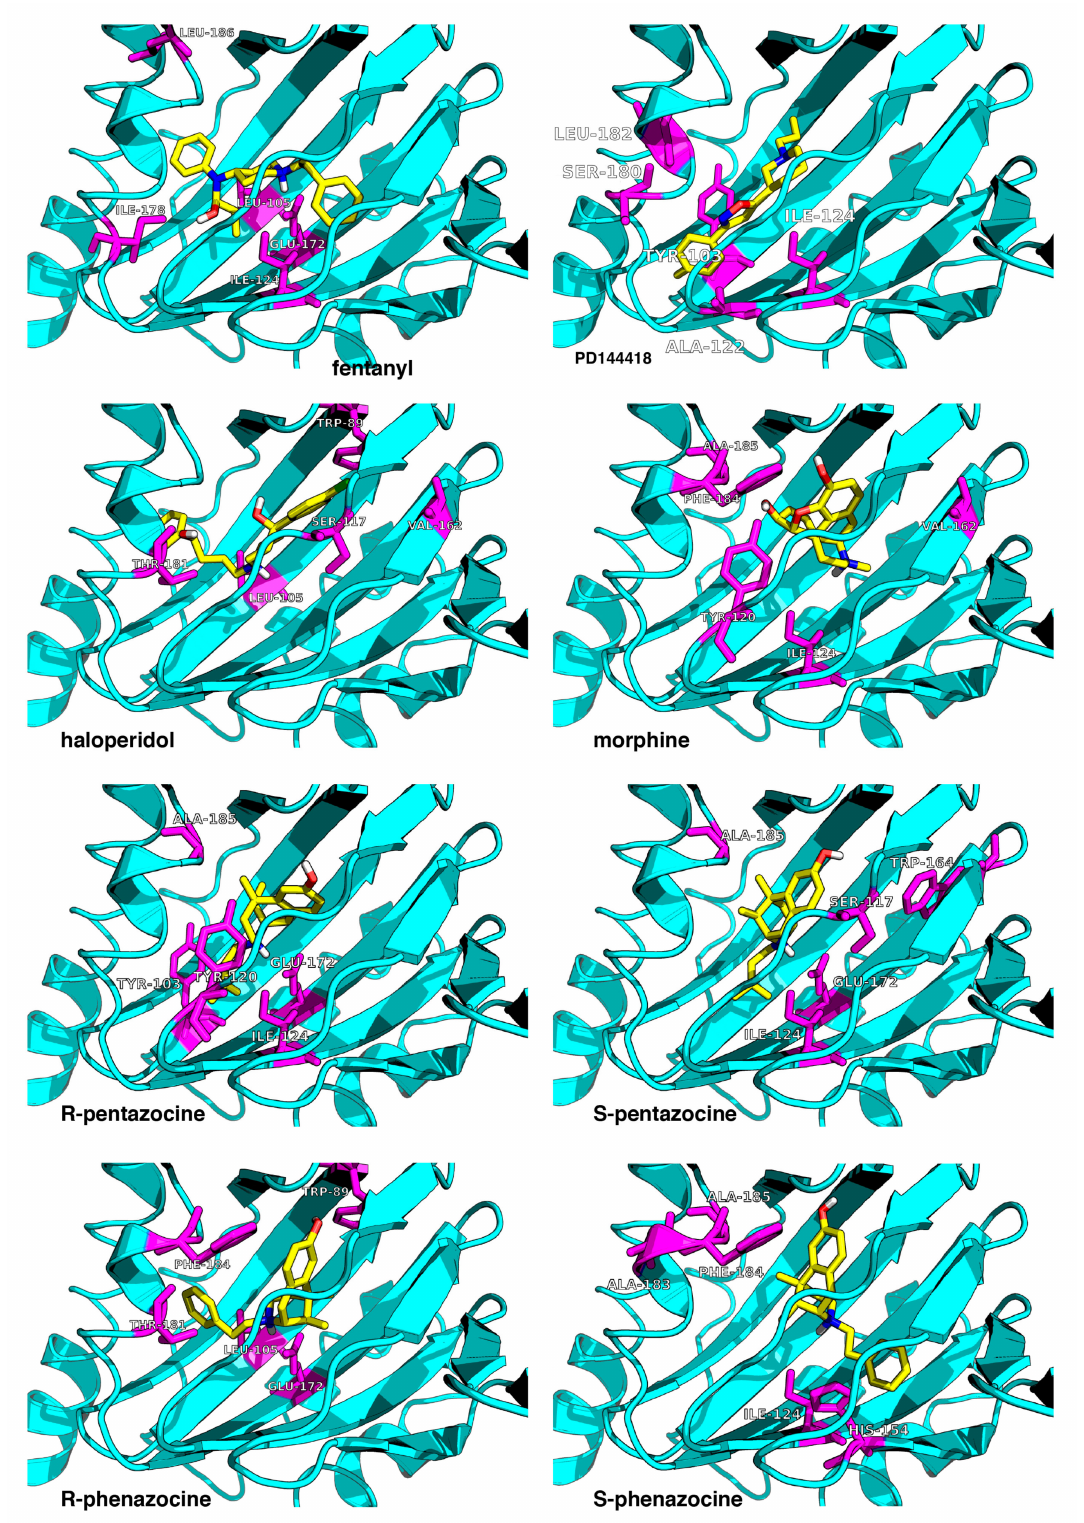
Figure 2. Top-scored docking poses for the seven studied ligands (yellow) bound to the receptor (cyan). The eighth ligand is PD144418 (top right corner). The receptor’s residues most frequently contacted during the MD simulations are shown in magenta. The image is a zoomed view of the receptor binding